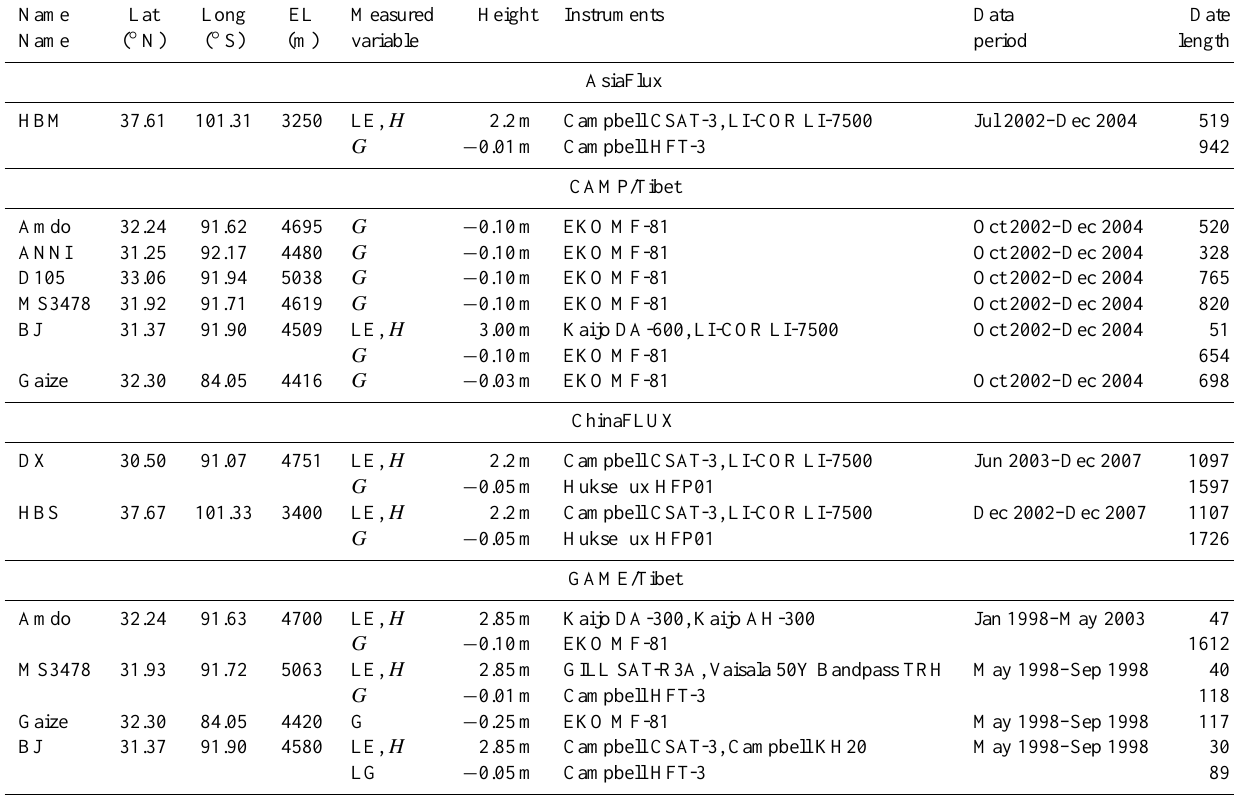
Table 2. Information of the ground observation sites over the TP with measurement of latent heat flux (LE), sensible heat flux ( H ), and ground heat flux ( G